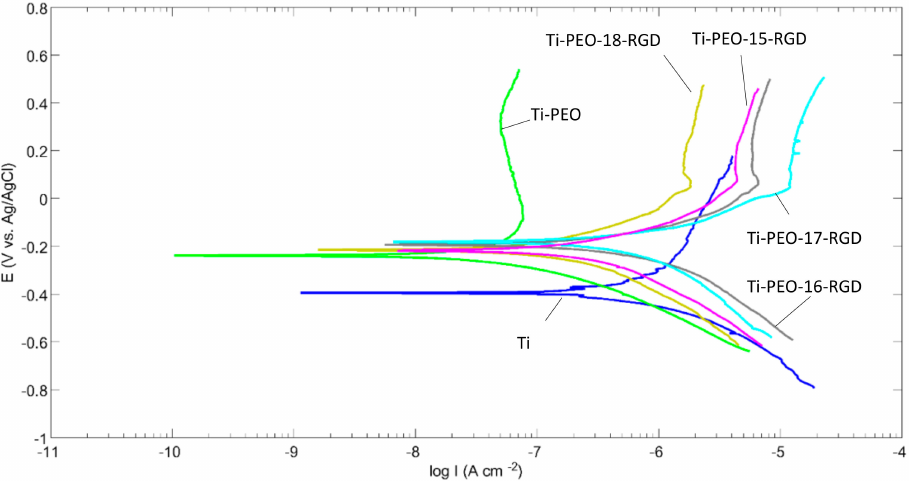
Figure 4. Polarization curves in Ringer’s solution for the Ti samples, with PEO coating, and RGD